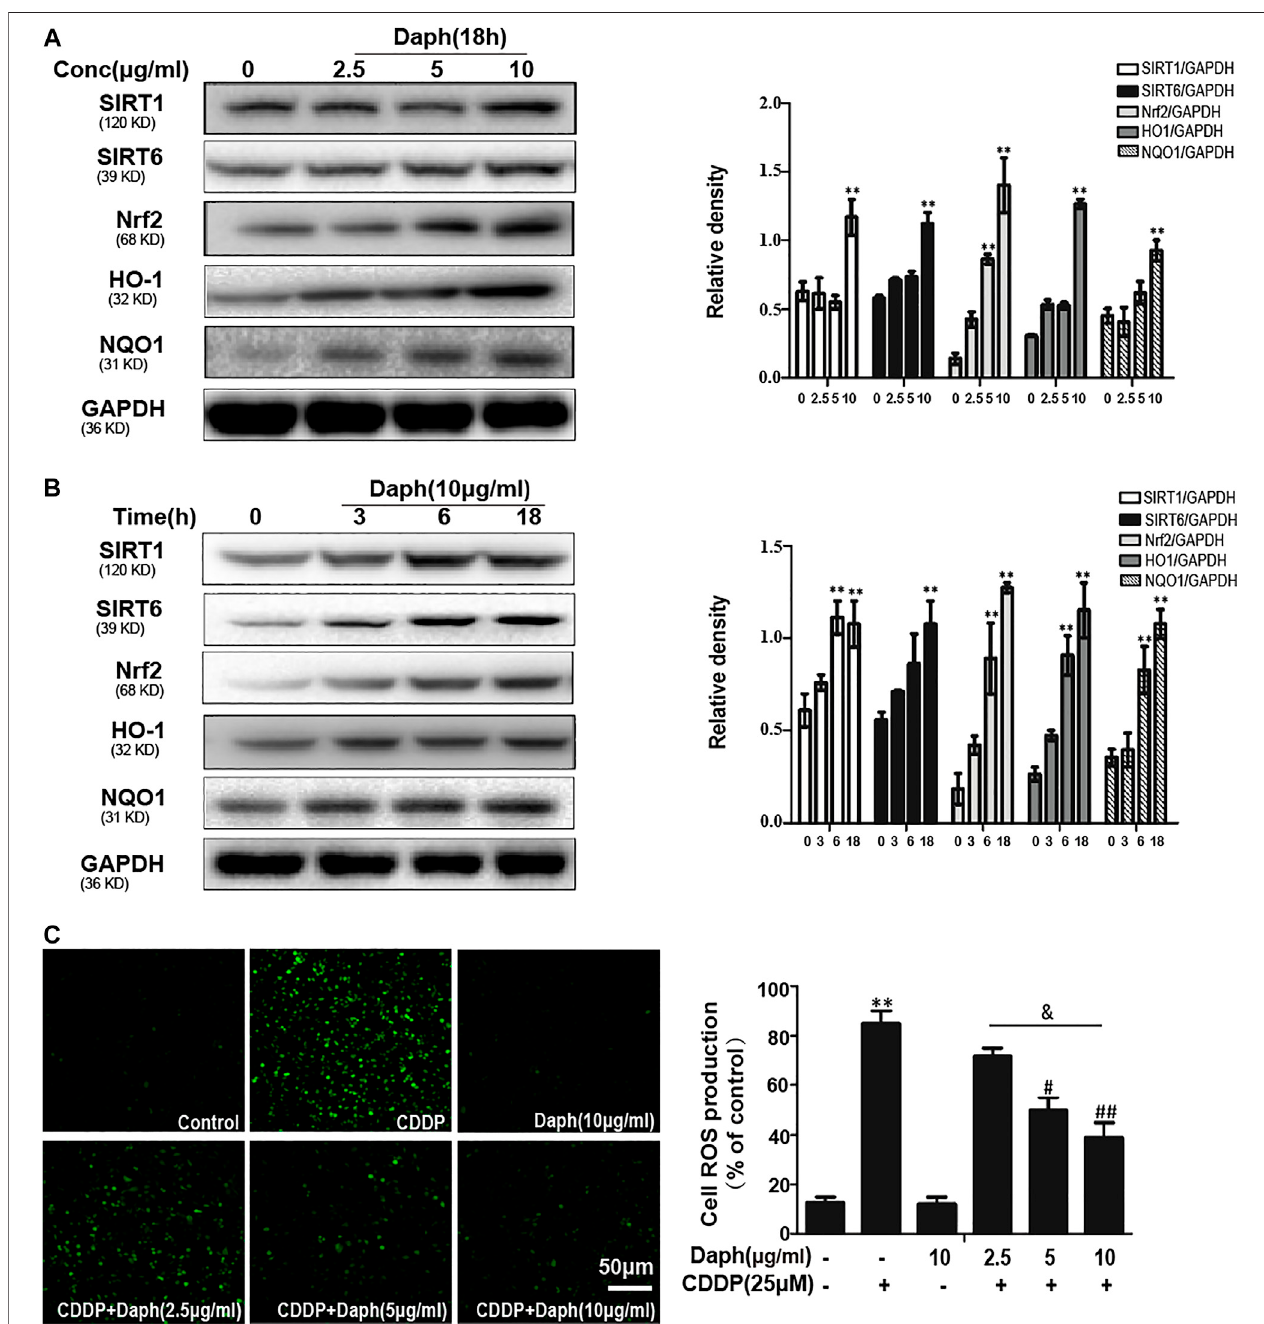
FIGURE 8 | Daph activated antioxidant pathway and suppressed CDDP-induced ROS in HK2 cells. (A,B) Western blots analysis showing the expression levels of relatedproteininHK2cells (C) HK2cellsweretreatedwithDaph(2.5,5and10 μ g/ml)for18 h,treatedwithCDDP(25 μ M)for10 min,DCFH-DAstainingassaywasused todetect ROSgeneration.Dataarepresentedasthemean ± SEM,and arerepresentative ofthree independent experiments. ** p < 0.01vs.thecontrolgroup;# p < 0.05 and ## p < 0.01 vs. the CDDP group; & p < 0.05 vs. the Daph (10 μ g/ml) plus CDDP group.